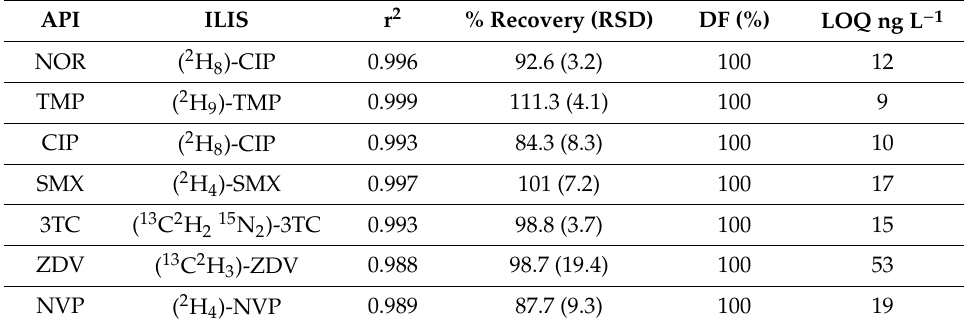
Table 3. LC-MS / MS-ESI method qualification results. API = active pharmaceutical ingredient, ILIS